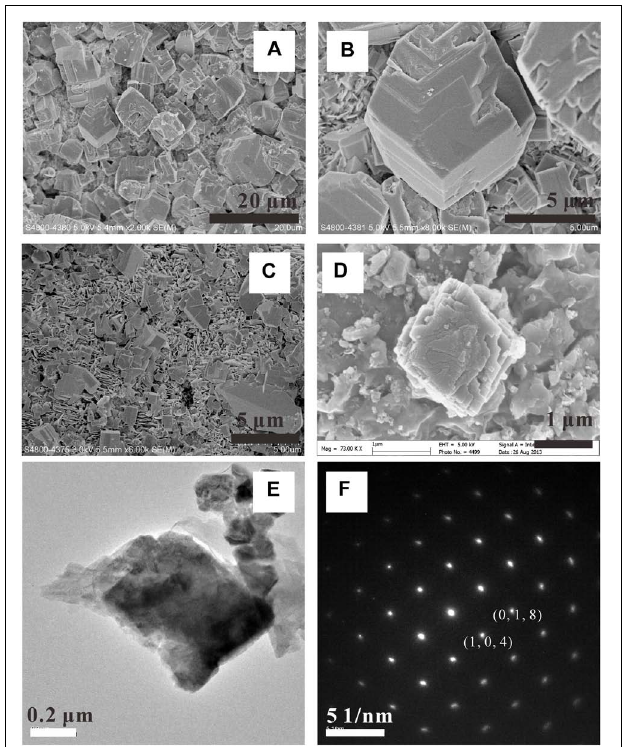
FIGURE 5 | SEM (A–D) and TEM (E) characterizations of illite formed in [H 2 O-CO 2 ]-basalt system. The SAED pattern (F) shows a set of clear diffraction spots indicating single crystalline nature.